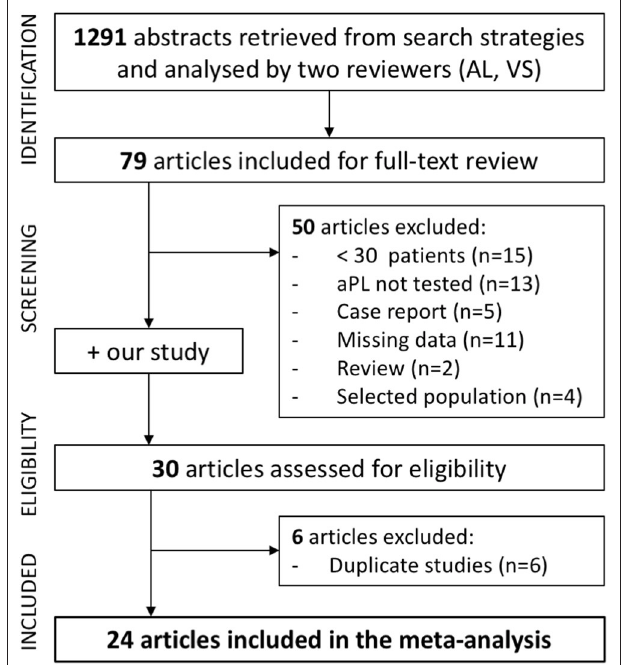
FIGURE 2 | Flowchart illustrating the study selection process for meta-analysis of the prevalence of aPL in